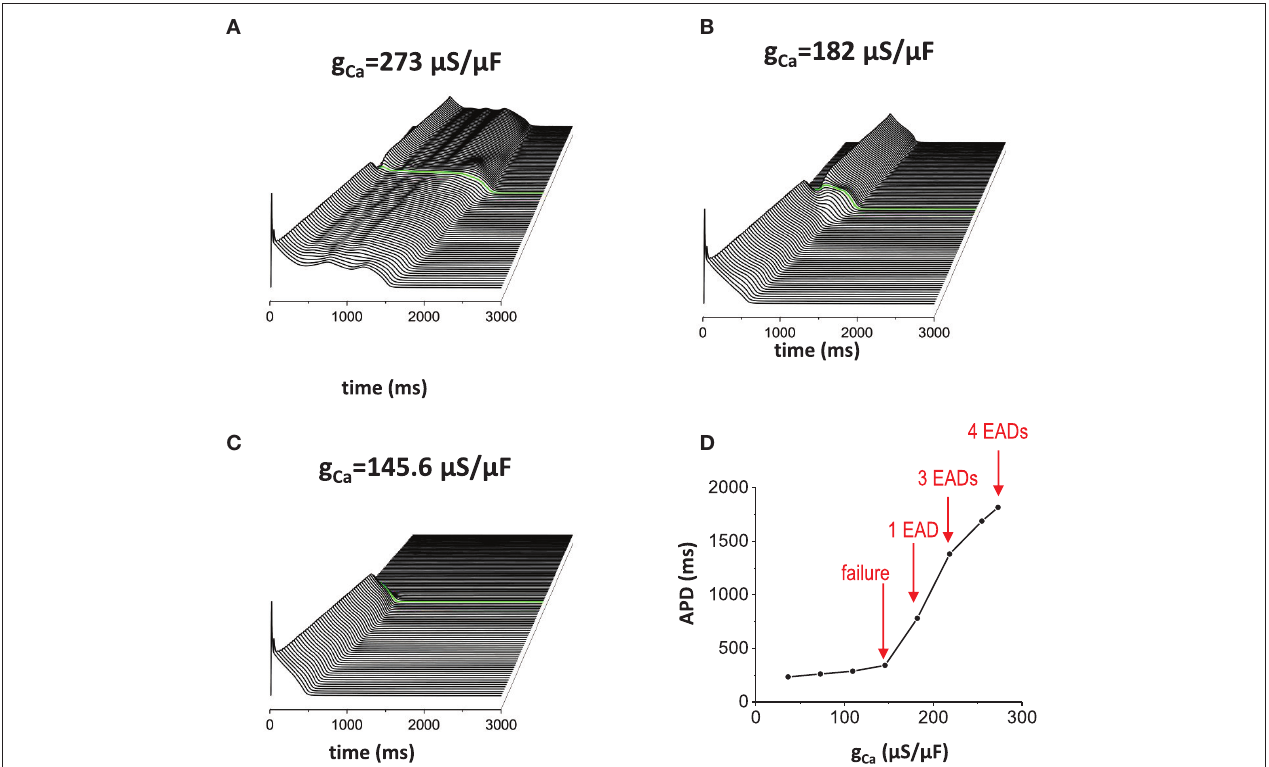
FIGURE 5 | Effects of the inward current. When inward current ( I CaL ) is increased, EADs occur without the non-excitable gap region. In addition, non-excitable gap promotes EADs further (A) . g Ca 273 µ A/ µ F. Without the non-excitable gap region, 3 EADs were observed. Near the gap region, 4 EADs were observed. The = maximum APD is 1816ms. (B) g Ca 182 µ A/ µ F. Control. The maximum APD is 781ms. (C) g Ca = vs. g Ca